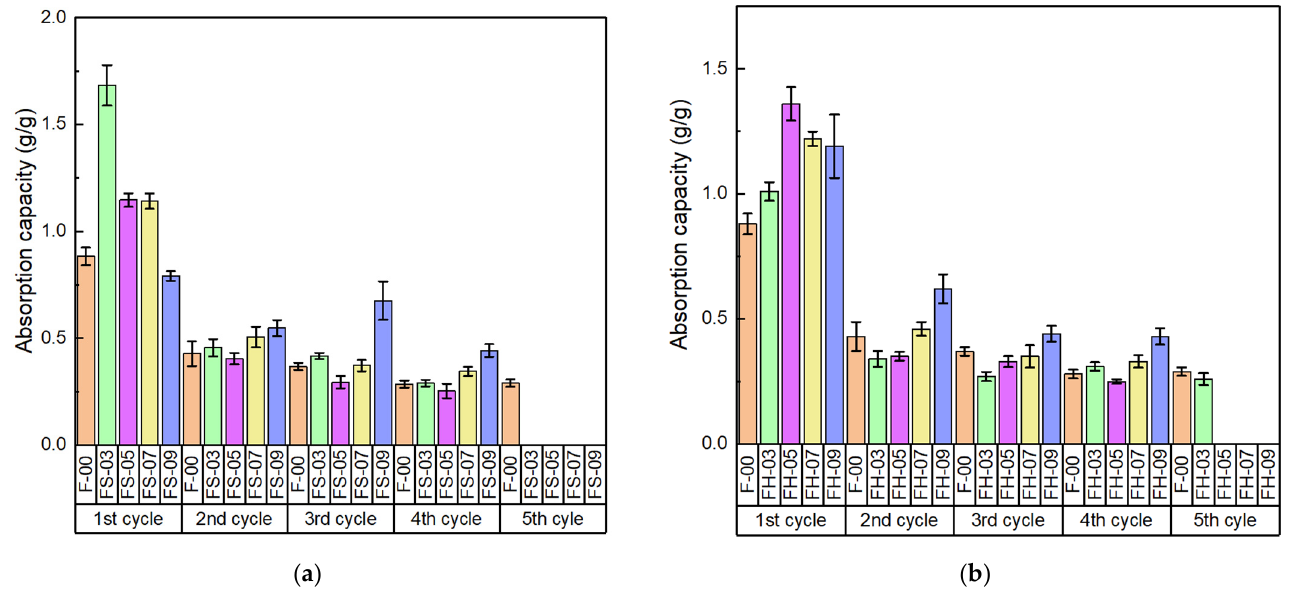
Figure 10. Absorption capacity of ( a ) silica-filled NRF and ( b ) silica–lignin hybrid-filled NRF at various cycles.